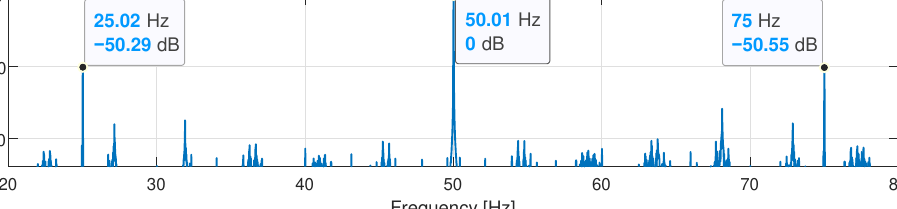
Figure 23. Spectra of the simulated currents of the motor described in Appendix A, for different degrees of mixed eccentricity (static eccentricity δ s , dynamic eccentricity δ d ). Top: healthy motor ( δ s = 0, δ d = 0). Below, from top to bottom, increasing mixed eccentricity faults ( δ s = 0.05, δ d = 0.05), ( δ s = 0.1, δ d = 0.05), ( δ s = 0.05, δ d = 0.1), and ( δ s = 0.1, δ d = 0.1). This last spectrum displays the fault harmonics closest to the measured ones in Figure 22, which is compatible with a degree of mixed eccentricity fault with ( δ s = 0.1, δ d =